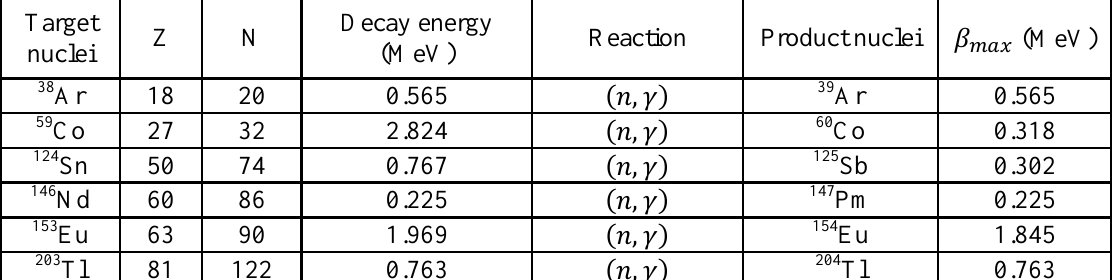
Table 2: The target nuclei used for production the pure emitters for fabrication the nuclear